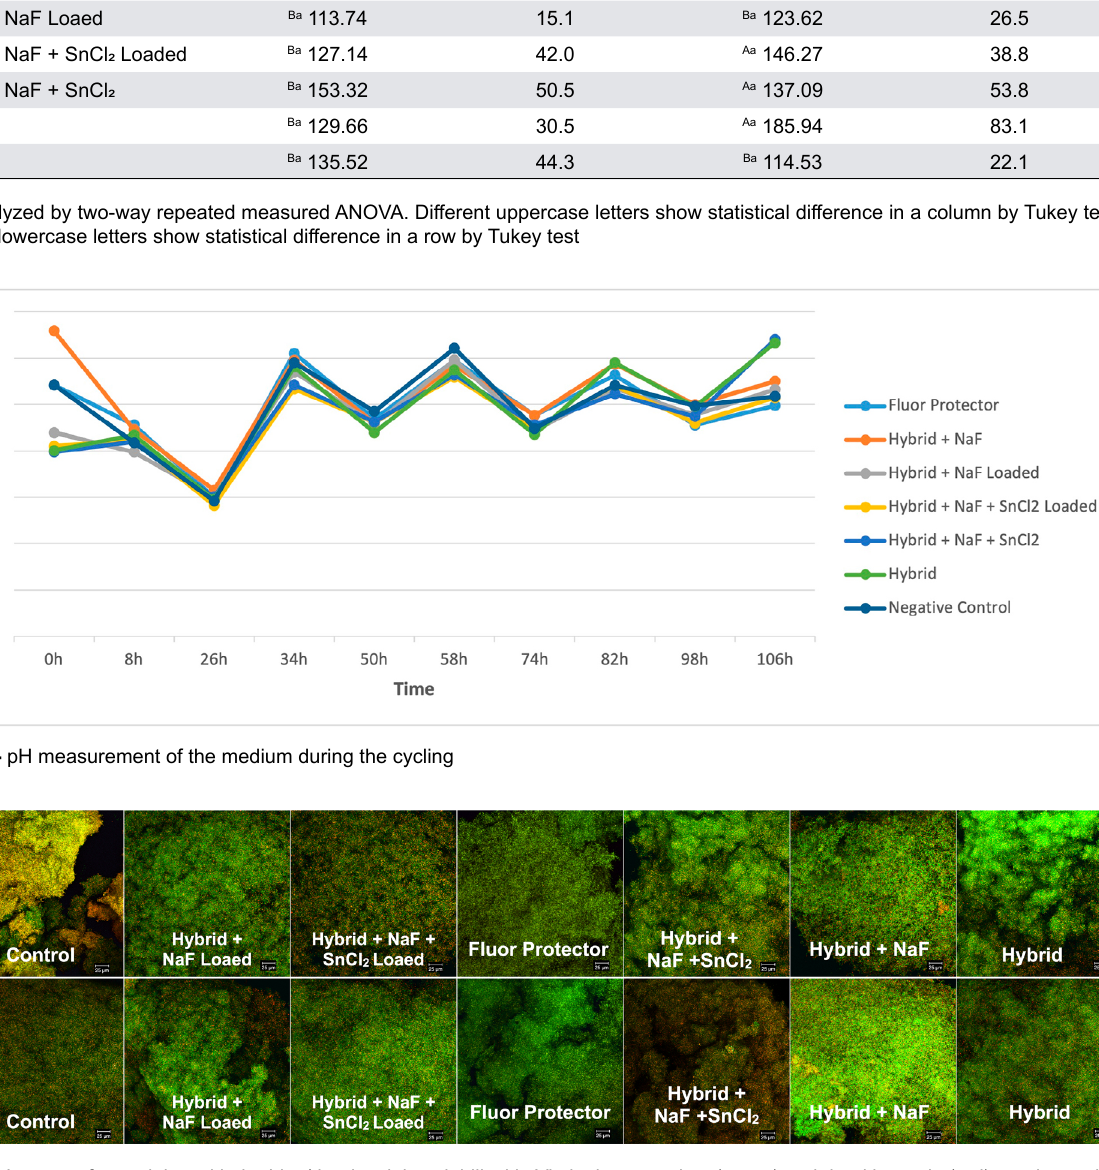
Figure 7- Images after staining with the Live/dead staining viability kit. Vital microorganism (green) and dead bacteria (red) are detectable at the enamel surface areas in the under-treatment and adjacent to treatment, for all experimental